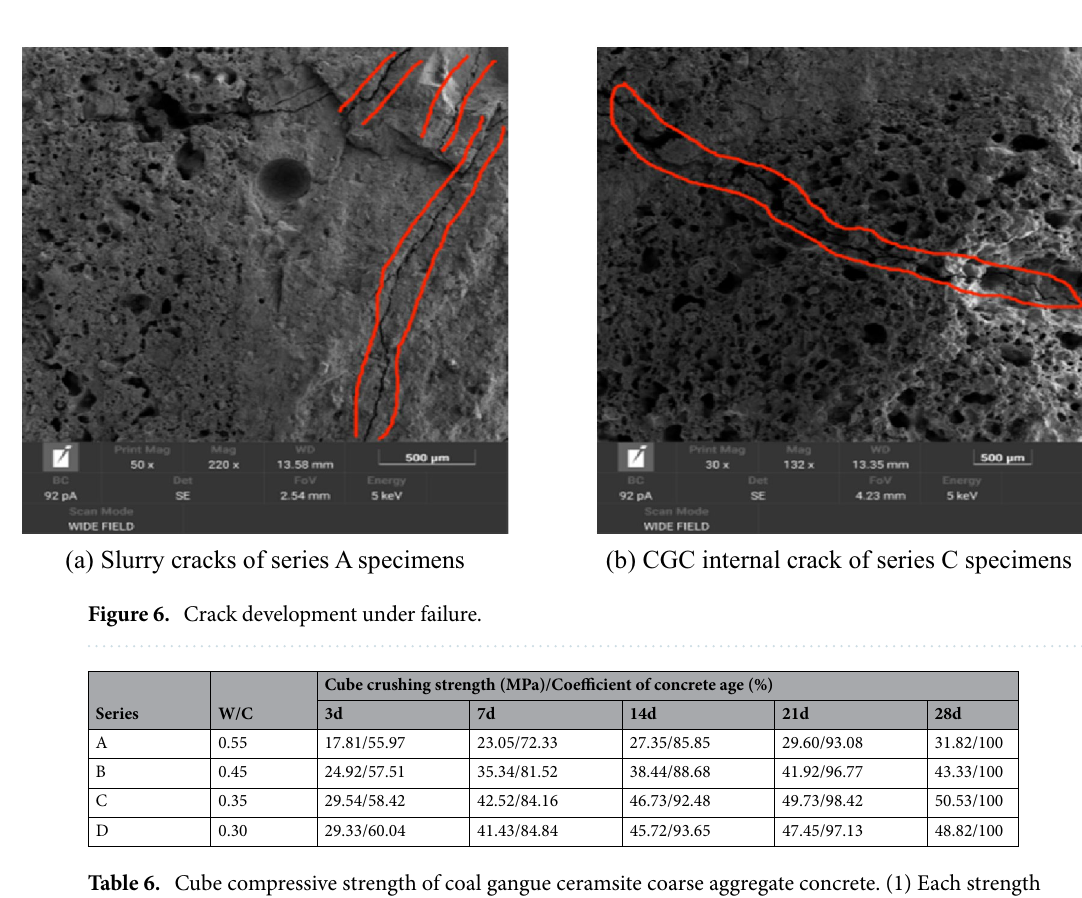
Table 6. Cube compressive strength of coal gangue ceramsite coarse aggregate concrete. (1) Each strength is the average value of three test specimens. (2) The coefficient of concrete age is the ratio of the compressive strength of concrete at different ages to that at 28 days.